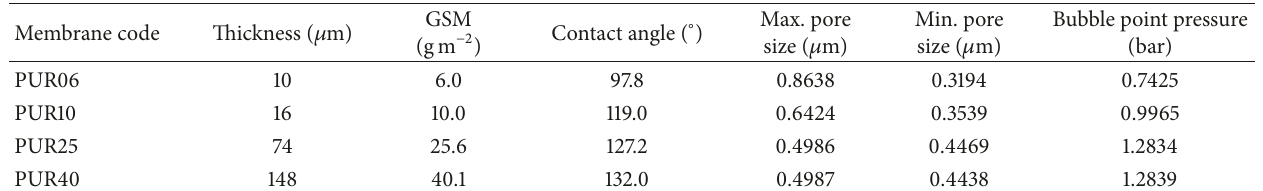
Table 1: Membrane structural properties.